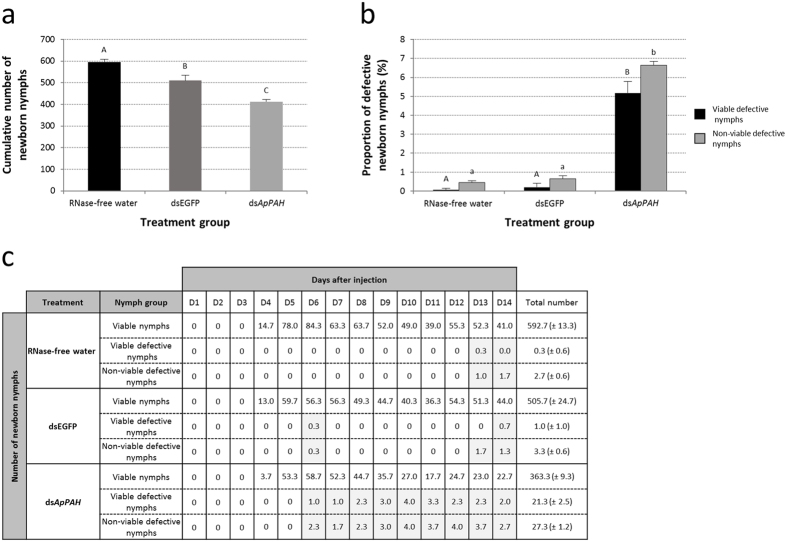
Impact of dsApPAH on aphid fecundity.(a) Cumulative number of progeny (at day 14) laid by the different treatment groups: aphids injected with RNase-free water (black), dsEGFP (grey) or dsApPAH (light grey), respectively. For each treatment group, results are reported as means (±SD) of three independent biological replicates. Each biological replicate was composed of one group of 10 aphids. Data were analyzed by one-way ANOVA followed by a post hoc multiple comparisons test (Tukey’s HSD test). Treatment groups labeled with different letters are significantly different (P < 0.05). (b) Proportion of viable defective (black) and non-viable defective (light grey) nymphs laid by the different treatment groups: aphids injected with RNase-free water, dsEGFP or dsApPAH, respectively. For each treatment group, results are reported as means (±SD) of three independent biological replicates. Each biological replicate was composed of one group of 10 aphids. Data were analyzed by one-way ANOVA followed by a post hoc multiple comparisons test (Tukey’s HSD test). Treatment groups labeled with different letters are significantly different (P < 0.05). (c) Variation in the number of newborn nymphs in relation to the different RNAi treatments: RNase-free water, dsEGFP or dsApPAH. Newborn nymphs were classified into three groups: viable, viable defective and non-viable defective nymphs. Results are reported as means (day by day report), or as means ± SD (cumulative number of newborn nymphs at the end of the follow-up period) of three independent biological replicates. Days with defective nymph production are highlighted in grey.